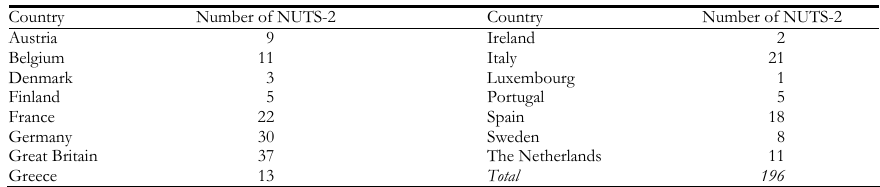
NUTS-2 (Nomenclature of Territorial Units for Statistics, Eurostat) belonging to 15 European countries included in the analysis Country Number of NUTS-2